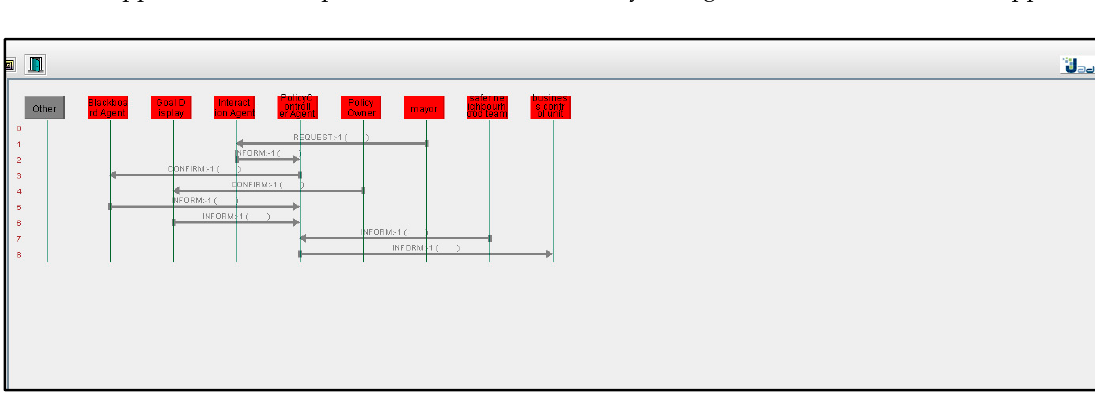
Figure 14. System Output-Communication among Stakeholders.